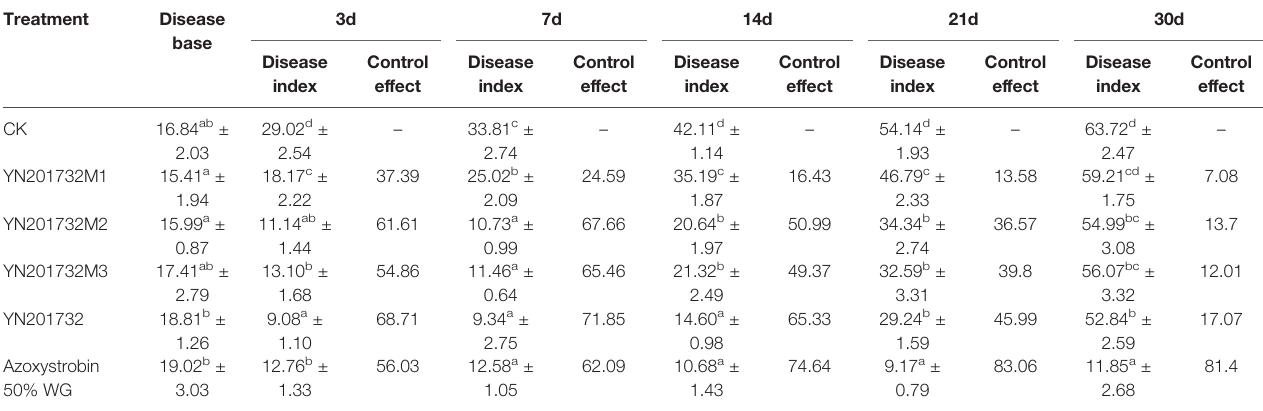
TABLE 4 | Control effect of Bacillus amyloliquefaciens YN201732 and the mutants on tobacco powdery mildew in the greenhouse.